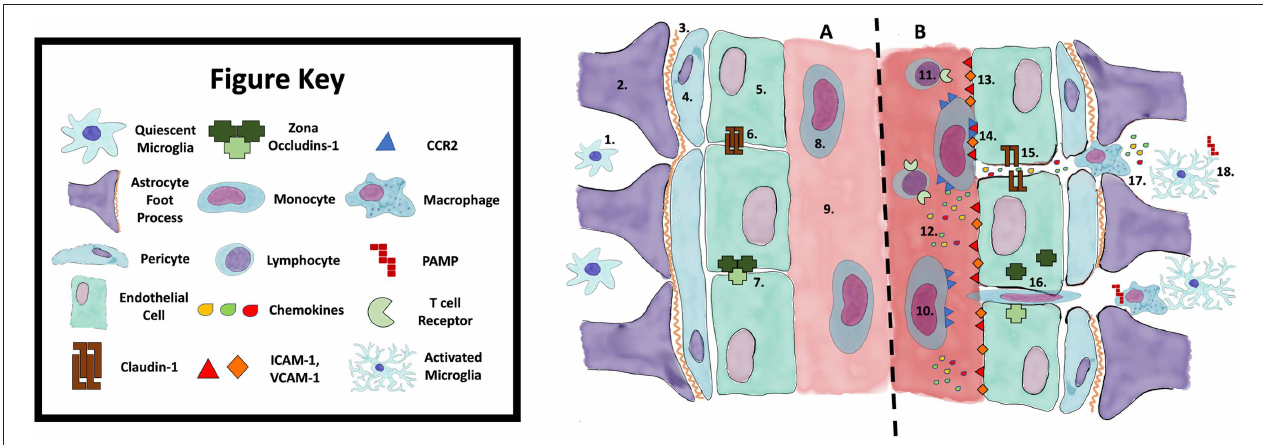
FIGURE 1 | Blood Brain Barrier Function (A) and Dysfunction (B) . 1. Quiescent Microglia; 2. Astrocyte foot process; 3. Basement membrane; 4. Pericyte; 5. Endothelial cell; 6. Claudin-1; 7. Zona occludins-1; 8. Monocyte; 9. Vessel lumen; 10. Activated monocyte; 11. T-lymphocyte; 12. Chemokines; 13. ICAM-1, VCAM-1; 14. Monocyte initiating diapedesis; 15. Breakdown of tight junctions; 16. Infiltrating monocyte; 17. Macrophage; 18. Activated microglia via DAMP/PAMP. DAMP, Damage associated molecular pattern; PAMP, Pathogen associated molecular pattern; ICAM-1, Intracellular adhesion molecule 1; VCAM-1, Vascular cell adhesion